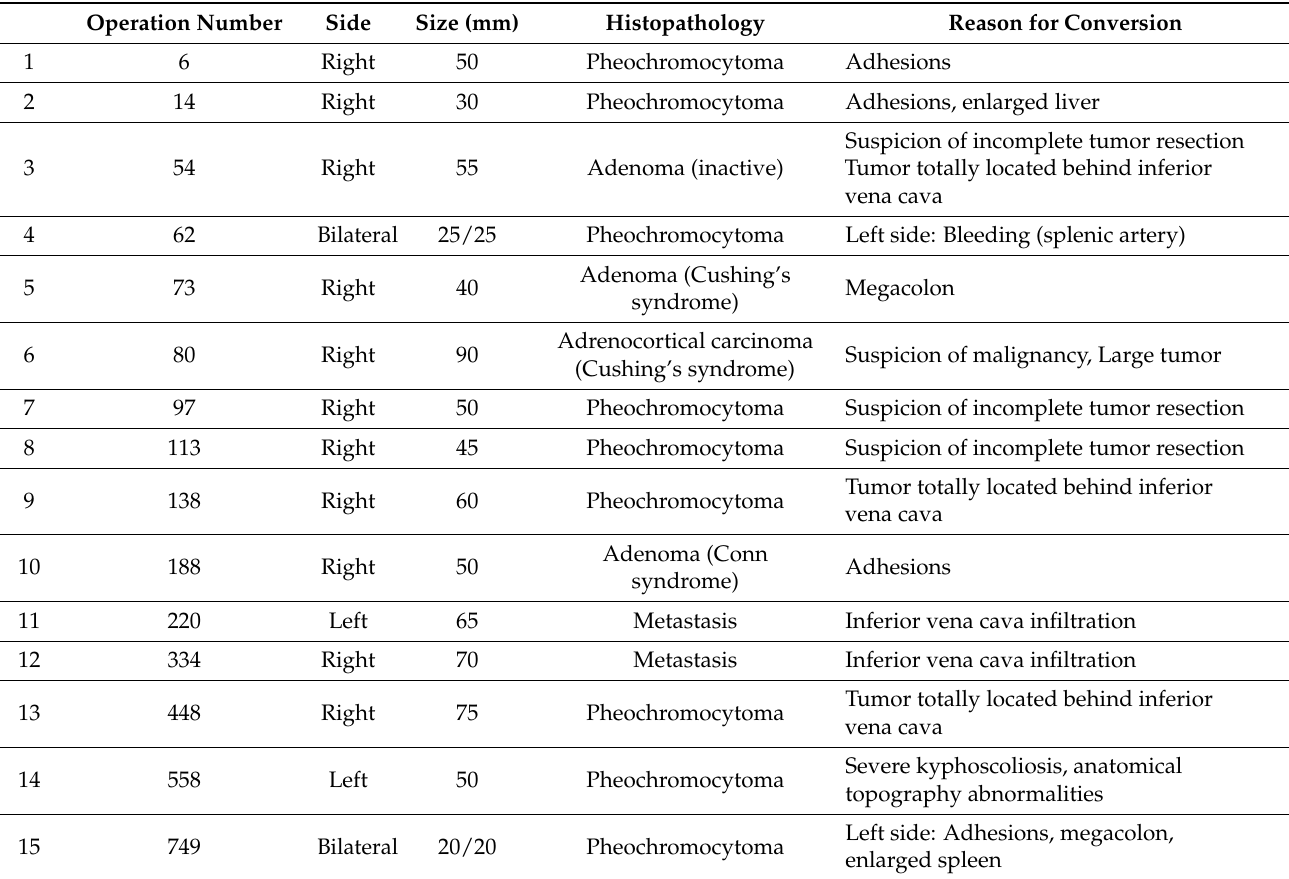
Table 3. Indications for conversion to open surgery.